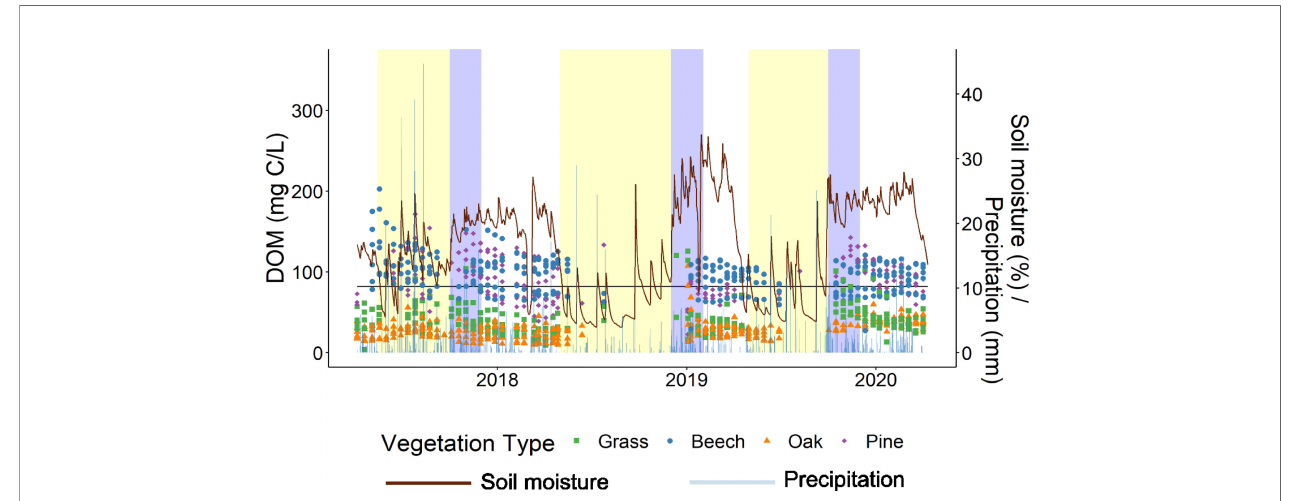
FIGURE 1 | DOM concentration per vegetation type between 2017 and 2021. Soil moisture (red) and precipitation (light blue) data are also plotted. Yellow periods indicate dry conditions, blue indicates rewetting conditions and white indicates moist conditions. Dry conditions and the point of rewetting were determined relative to the average soil moisture marked here as a black horizontal line. Rewetting conditions were determined as occurring for two months after the point of rewetting due to variation in the actual point of rewetting between different